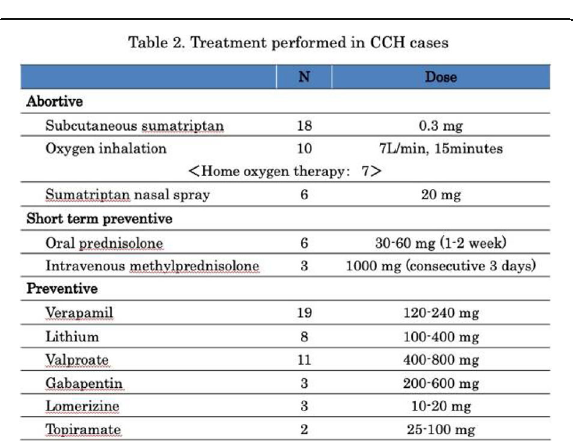
Table 2 (abstract P01). See text for